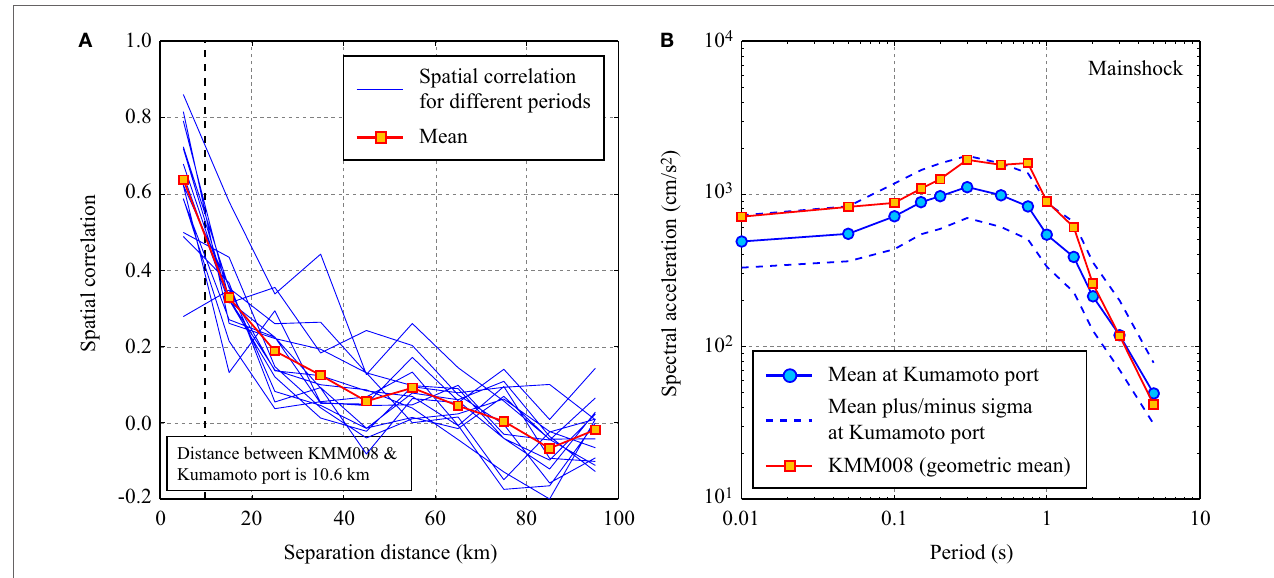
FigUre 10 | (a) Spatial correlation of ground motion residuals for the mainshock. (B) Estimated response spectra at Kumamoto port based on the ground motion model by Boore et al. (2014) and the spatial correlation, conditioned on the observed ground motions at